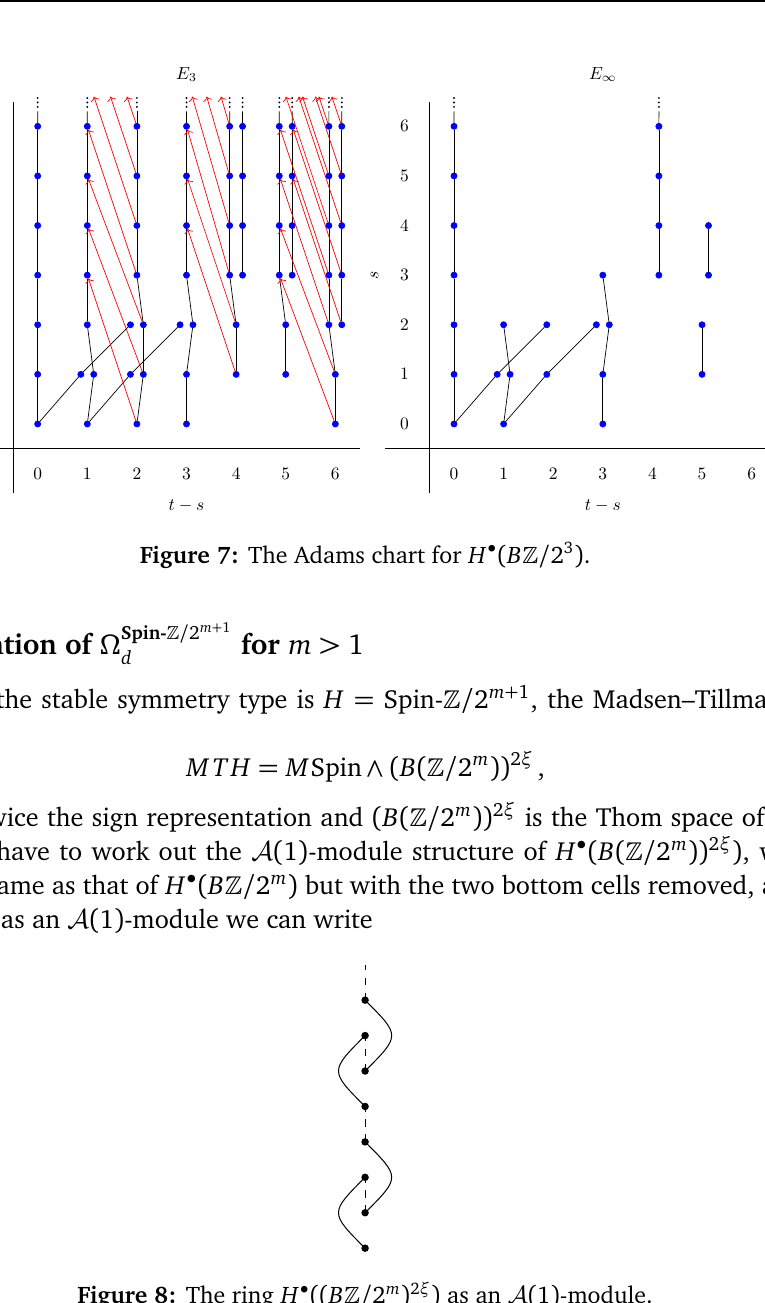
Figure 8: The ring H • (( B (cid:90) / 2 m ) 2 ξ ) as an